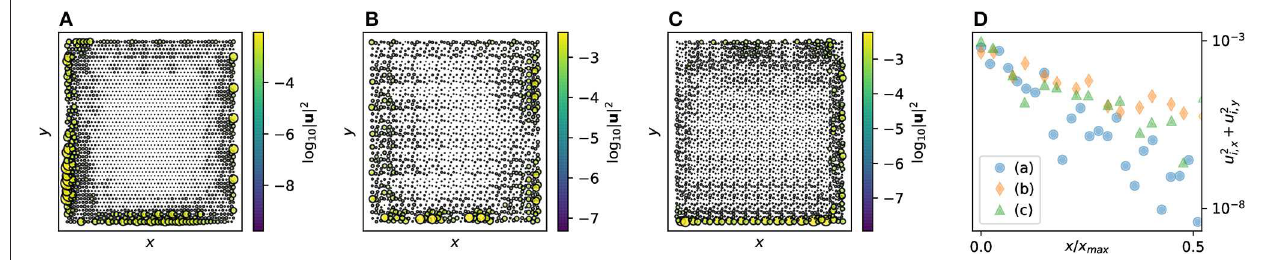
FIGURE 4 | Exponential localization of edge modes in rotating tuned mechanical Chern networks. We construct finite realizations consisting of (A) 12 14 14 unit cells of the three networks from Figure 1 , and plot a single eigenmode of the dynamical matrix D from Equation (9) with a frequency inside the bulk gap. × The values of (cid:127) are (cid:127) 0.1 (A) , (cid:127) 0.15 (B,C) , in the topological regime. The sizes and colors of the circles are proportional to the magnitude of the local node = = u 2 i , y , where u displacement u 2 i , x ( u x , u y ) is the eigenmode. Each network hosts topological modes entirely localized at the boundary. (D) We consider a small slice in + = y direction of the networks from (A–C) and again plot the magnitude of the local node displacement. For all three networks, the magnitude decreases